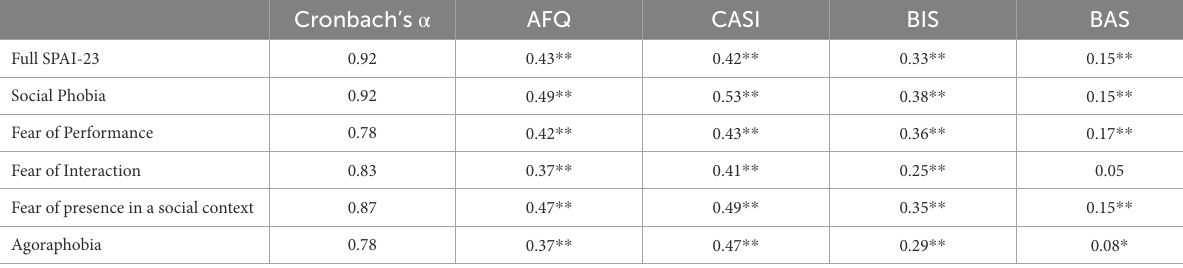
TABLE 7 Correlations between personality characteristics and SPAI-23 and